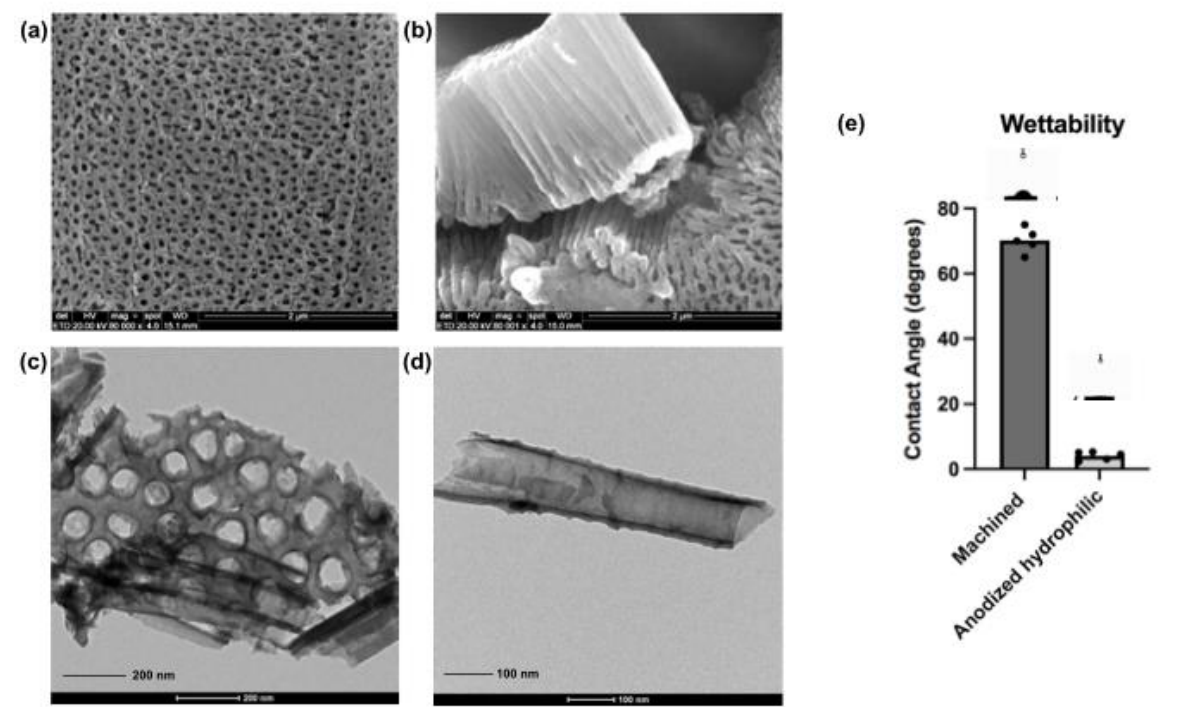
Figure 2. Morphological characterization and hydrophilicity properties of the nanotubular surfaces. Scanning electron microscopies from the anodized surfaces after surface treatment protocol, perpendicular view ( a ) and lateral view of the nanotubes ( b ) (SEM magnification—80,000 × , scale bars—2 µ m); Transmission electron microscopies from the anodized surfaces showing the nanotubular entrances and complete TiO 2 nanotubes structure ( c , d ) (TEM scale bar — 200 nm and 100 nm respectively). Additionally, contact angle measurements comparing control surfaces (machined) and anodized surfaces after reactive plasma application ( e ). The plasma application activated superhydrophilicity on the nanotubular surfaces.